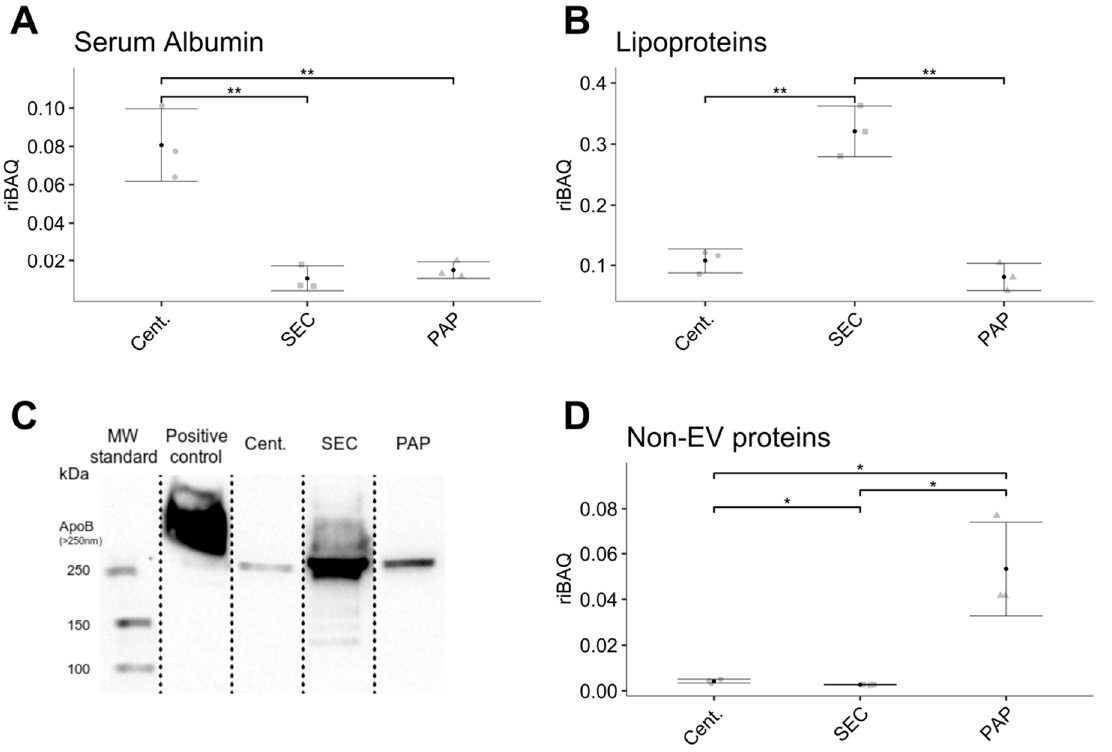
Figure 5. Difference in the co-isolation of contaminants such as serum albumin, lipoproteins, and other non-EV proteins between isolates produced by high-speed centrifugation (Cent.), size-exclusion chromatography (SEC), and peptide affinity precipitation (PAP). ( A ) High-speed centrifugation produced EV isolates with the highest abundance of serum albumin. ( B ) SEC isolates contained the highest amount of lipoproteins. ( C ) Immunoblotting confirms elevated levels of apolipoprotein B in isolates produced by SEC. ( D ) PAP isolates contained the highest amount of non-EV proteins. Error bars: Mean ± SD. Significance levels: * ( p -value < 0.05) and ** ( p -value < 0.01).